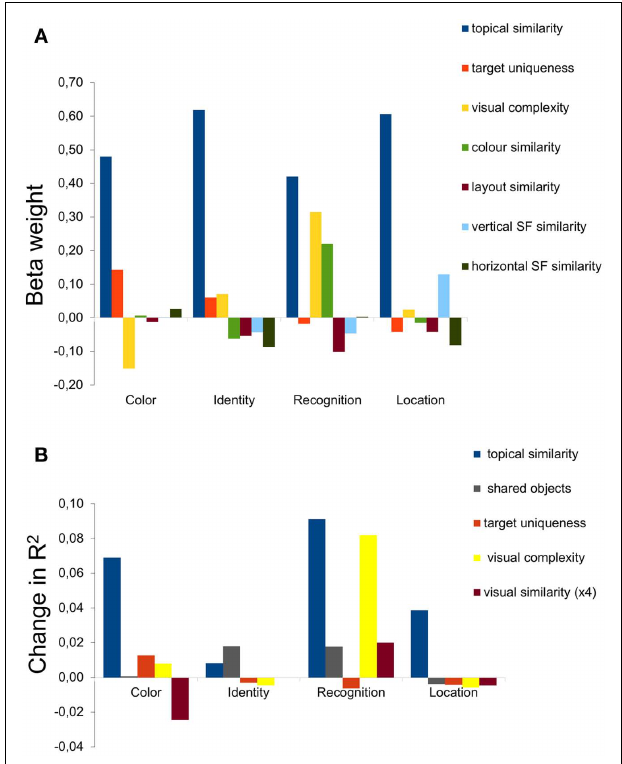
FIGURE 5 | Explanatory power of semantic versus low-level visual properties in a regression model, for the four types of questions. (A) The top panel shows the beta weight, a measure of explanatory power, for the semantic properties and the low-level visual properties (color brightness histogram, brightness layout, vertical spectral amplitude, and horizontal spectral amplitude, from left to right). Number of similar objects is not included in this panel due to the strong correlation ( r = 0.91) between topical similarity and number of shared objects. (B) The bottom row shows the change in the regression model from removing one of the factors, in order to show the relative contribution of semantic factors related to similarity between the target scene and the distracters (topic similarity and shared objects), target uniqueness of topic compared to other target images in the entire stimulus set, visual complexity of the target image and the low-level visual similarity between target and distracter images.The bars show the added advantage of including that variable in the regression model in terms of changes in adjusted R 2